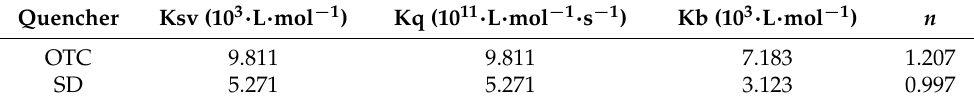
Figure 4. Stern-Volmer plots of OTC and SD for HA at temperature of 25 ◦ C. Table 1. The fitted association constant of the interaction between HA OTC and SD. Quencher